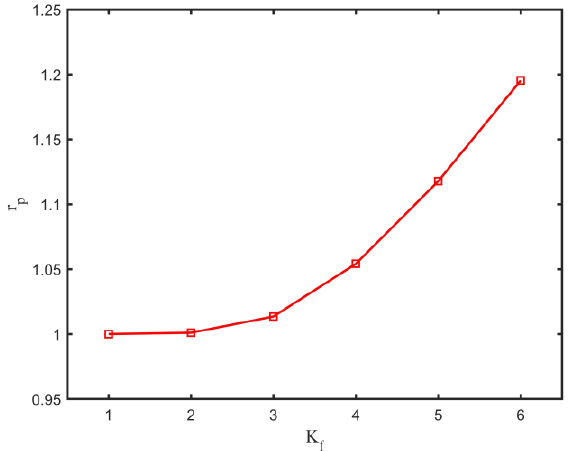
Figure 5. Effect of plasticity for Δσ n = 248.7 MPa, K ′ = 923 MPa, n ′ = 0.118.